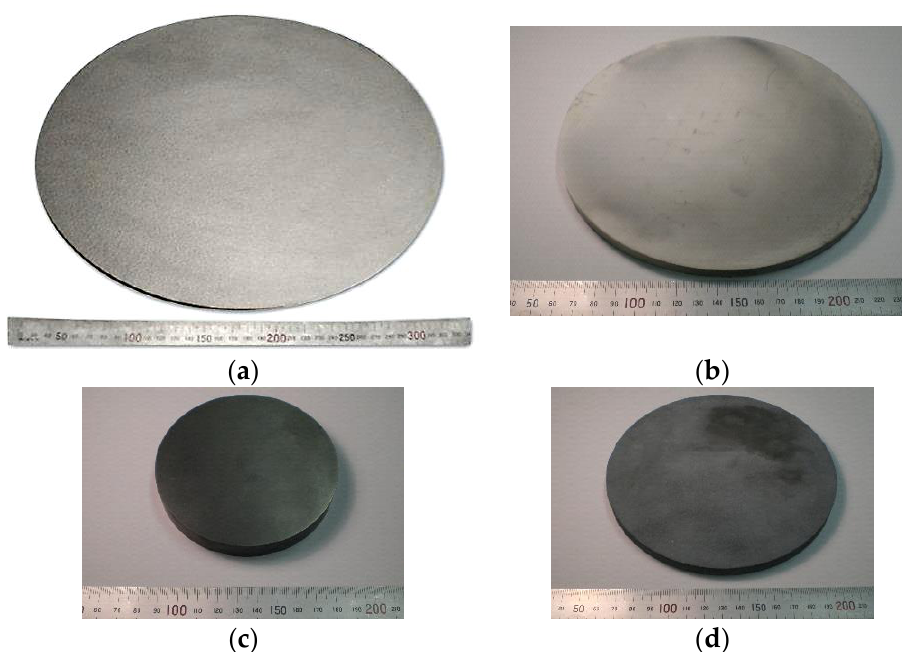
Figure 37. Example1 of large-size ceramics by SPS: ( a ) Material: Al 2 O 3 , R.D: 98–99%, Dimensions: Φ300 × 10 mm; ( b ) Ma- terial: Al 2 O 3, R.D: 99–100%, Dimensions: Φ200 × 10 mm; ( c ) Material: pure WC (no additives), R.D: 99–100%, Dimensions: Φ100 × 16 mm; ( d ) Material: SiC (with additives), R.D: 99–100%, Dimensions: Φ150 × 12 mm.